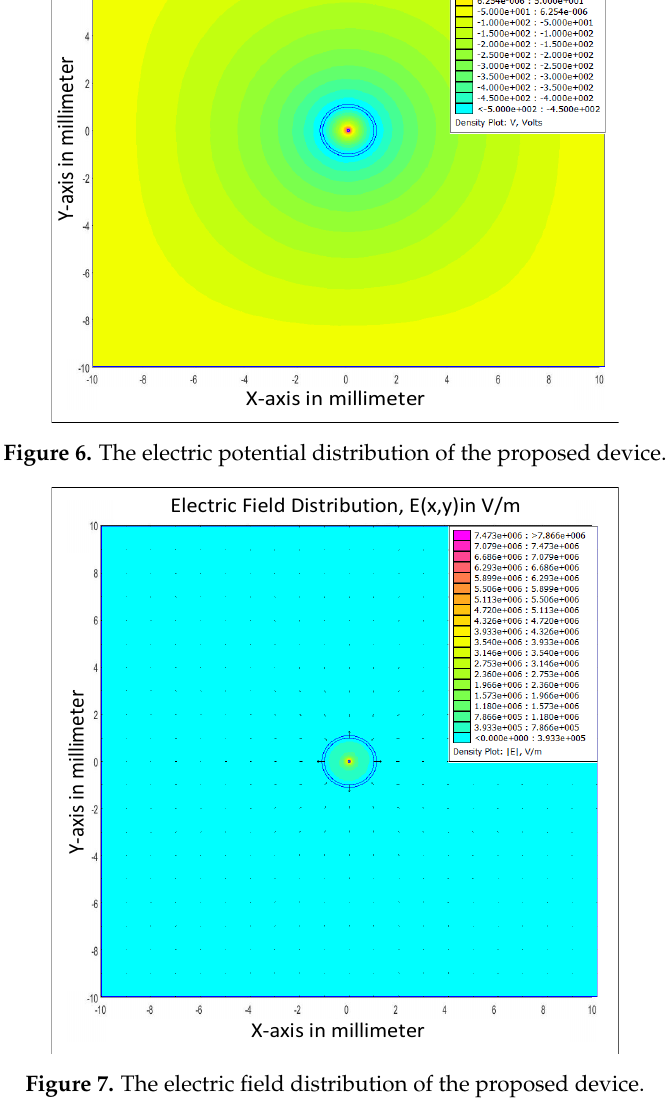
Figure 7. The electric field distribution of the proposed